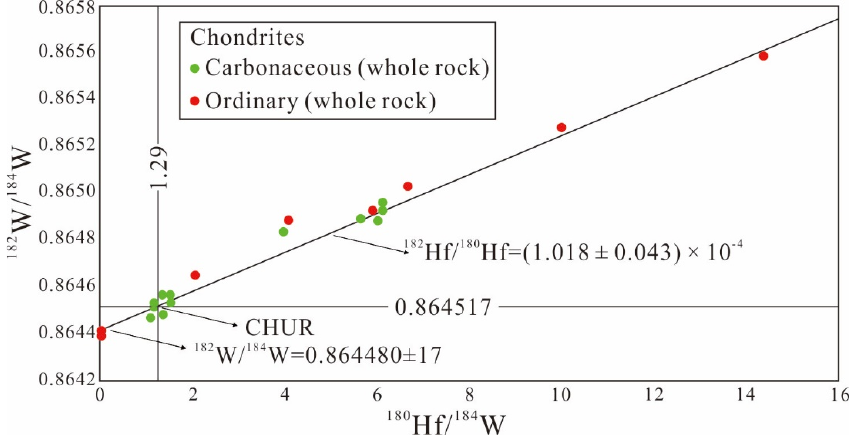
Figure 1. 182 Hf ‐ 182 W system fossil isochron diagram of primitive chondrites. Data are taken from [30–32].